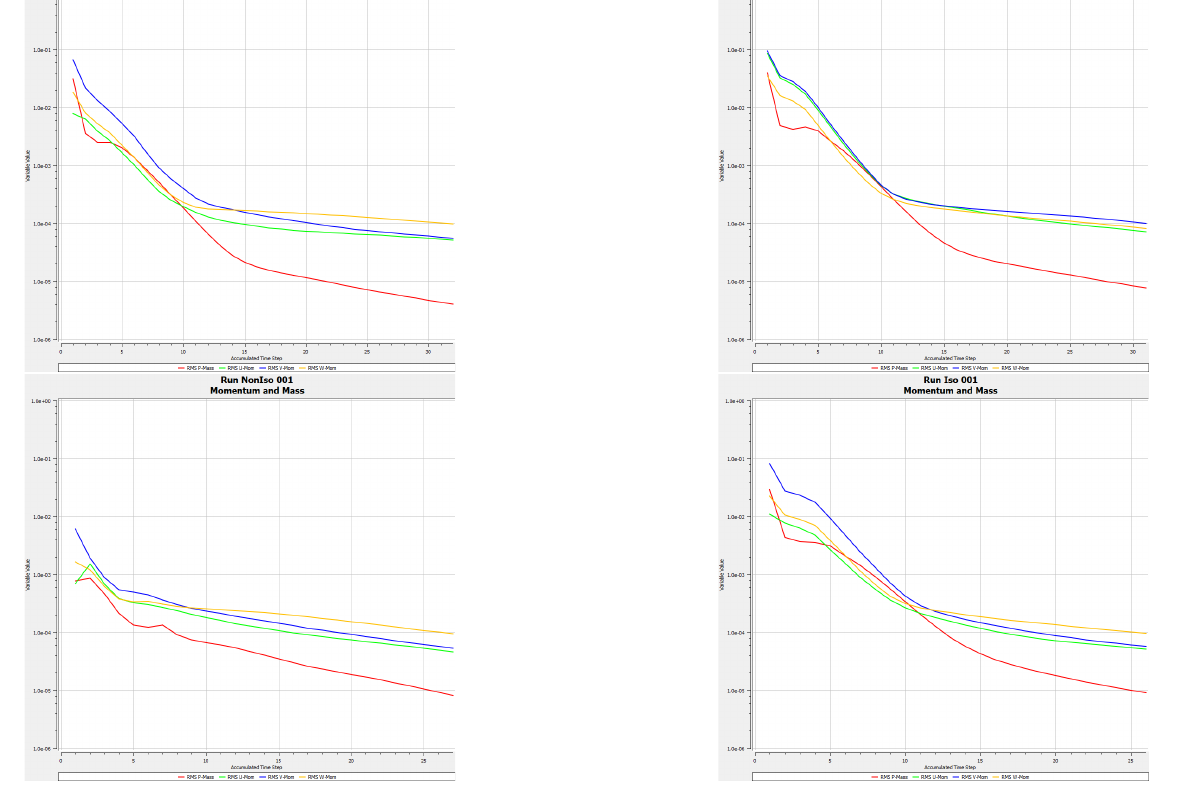
Figure A7. Residual convergence: first line (on the left ) Without stent, (on the right ) With plug, second line (on the left ) With stent and non-isotropic tensor, (on the right ) With stent and isotropic